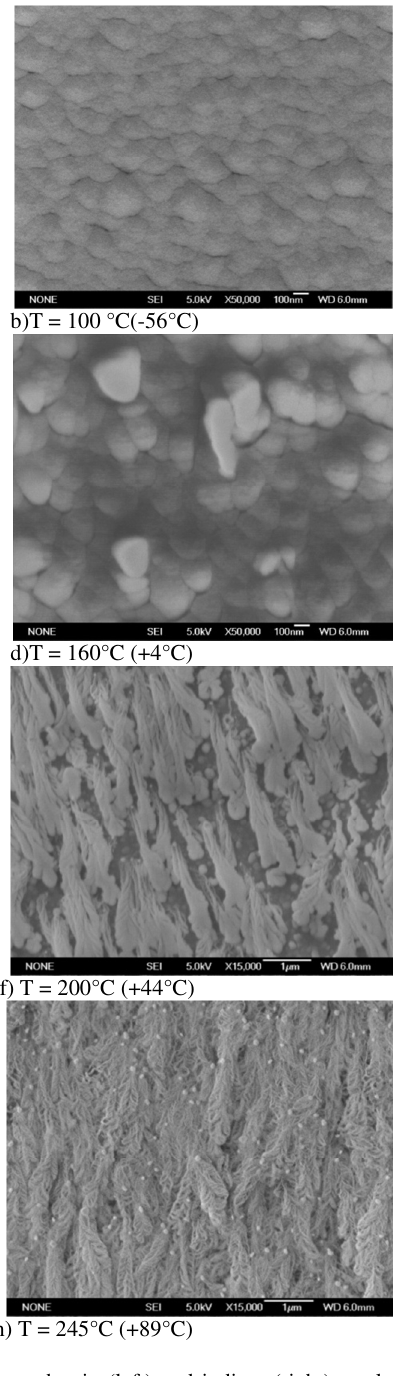
Fig. 2. SEM images of the silica nanowire structures grown on the tin (left) and indium (right) catalysts at temperatures of (a) 200 °C, (b) 100 ° C, (c) 245 °C, (d) 160°C, (e) 270 °C, (f) 200 °C, (g) 335°C, (h) 245 C. (The synthesis temperature is indicated under each image, and the difference between the synthesis temperature and the eutectic temperature is given in